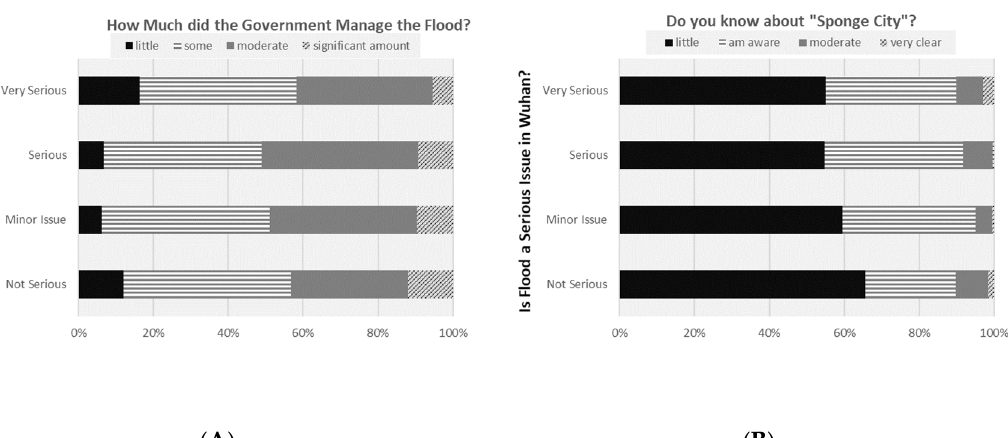
Figure 6. The relationship between the perception of the seriousness of flood (Q5) and ( A ) the perception of flood management conducted by the government (Q7); ( B ) the knowledge of Sponge City (Q8).